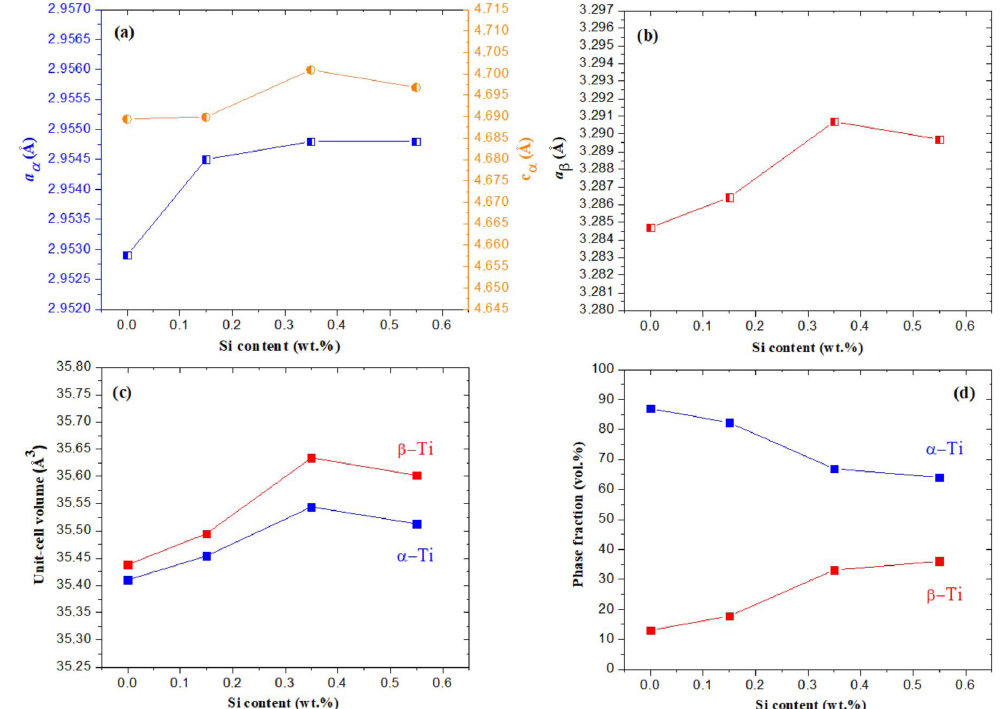
Figure 3. Variation of lattice parameters (a, b), unit-cell volumes (c) and phase fractions (d) of α and β as function of Si contents recorded for furnace-cooled Ti-15Nb-xSi